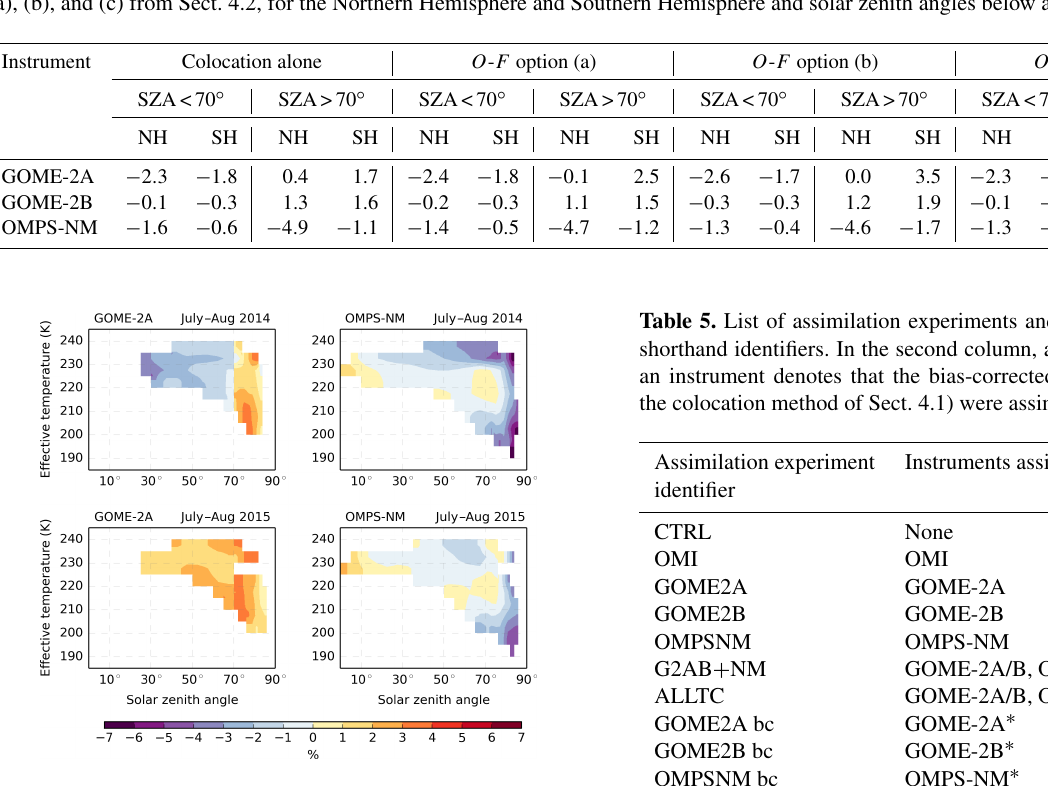
Figure 7. Mean total column ozone differences (%) between GOME-2A, OMPS-NM and colocated OMI-TOMS data as a func- tion of ozone effective temperature (Kelvin) and solar zenith an- gle (degrees) for the periods of July–August 2014 and July– August 2015. The colours blue to purple denote negative differences and the colours yellow to red refer to positive differences.